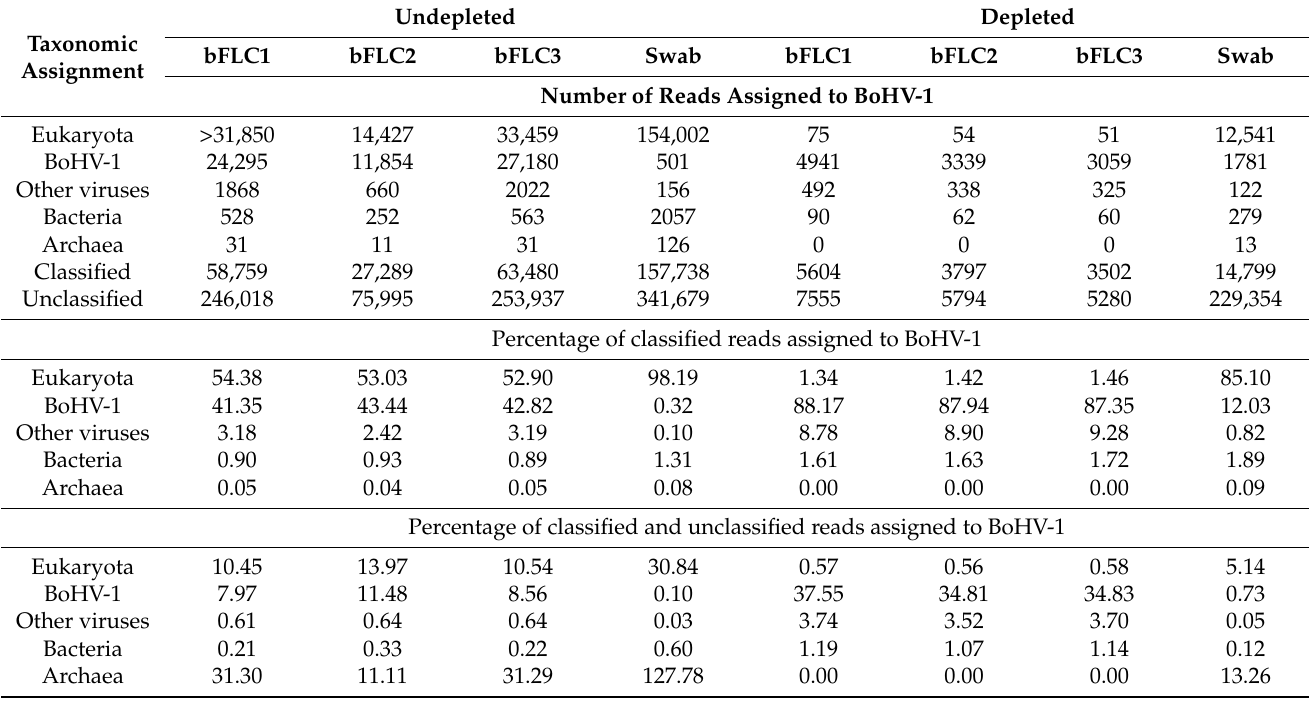
Table 2. Comparison of the read counts assigned to different taxa in undepleted and depleted